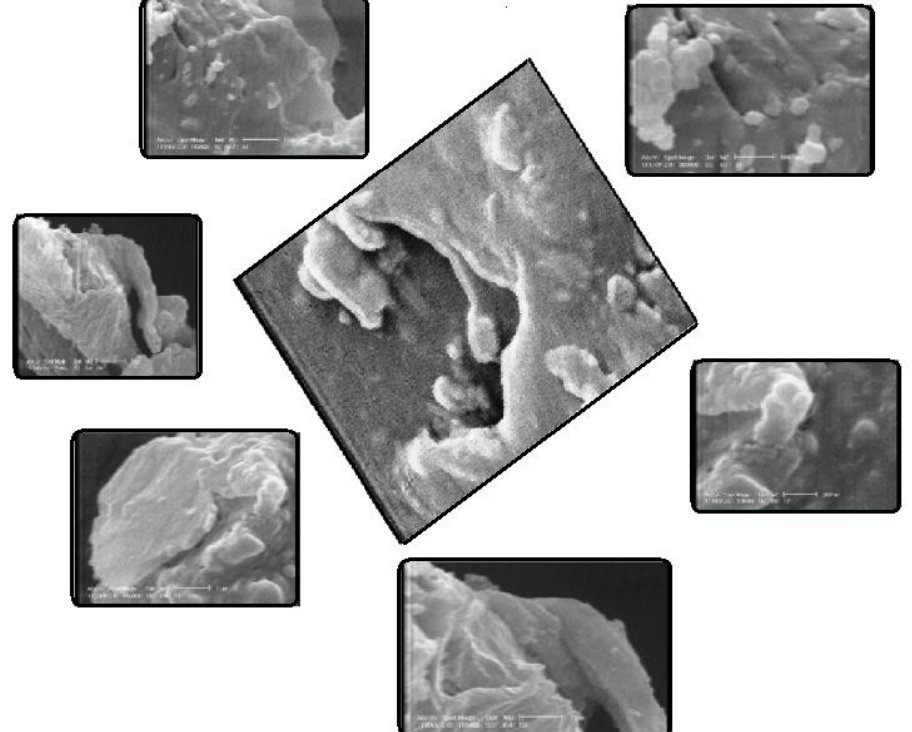
Fig. 4. Morphology of nano-etched Ingeo™ surface: 2D topography obtained by SEM (7500x, 15000 x and 30000 Figure 4. Morphology of nano-etched Ingeo ™ surface: 2D topography obtained by SEM (7500x, 15000 x and 30000 x)